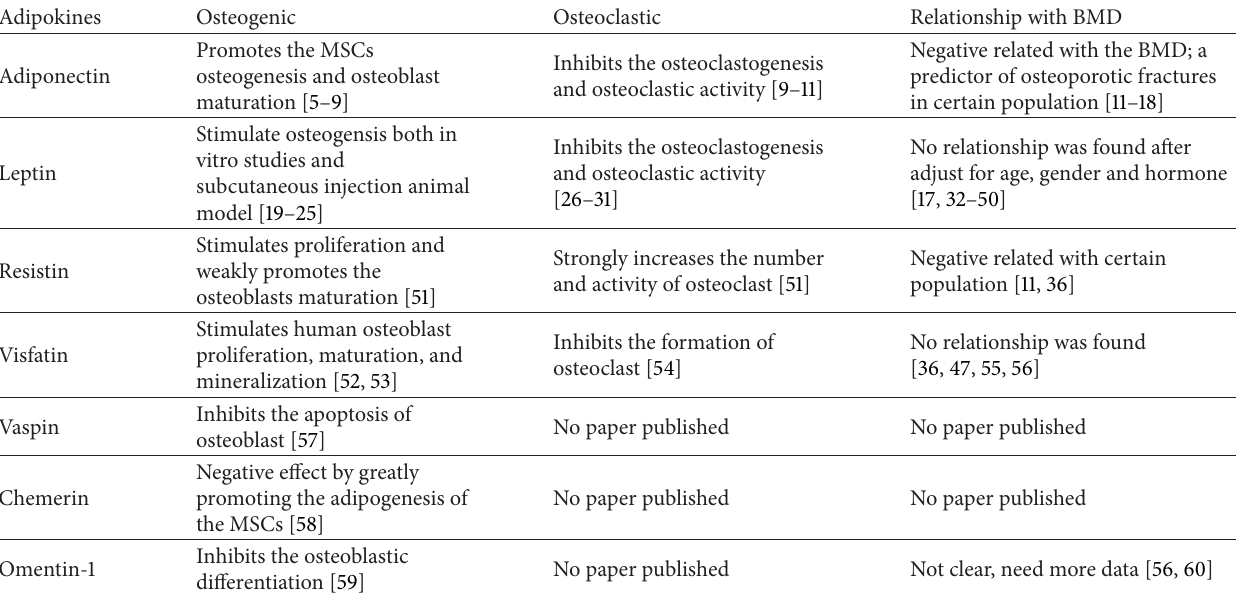
Table 1: Relation between adipokines and bone